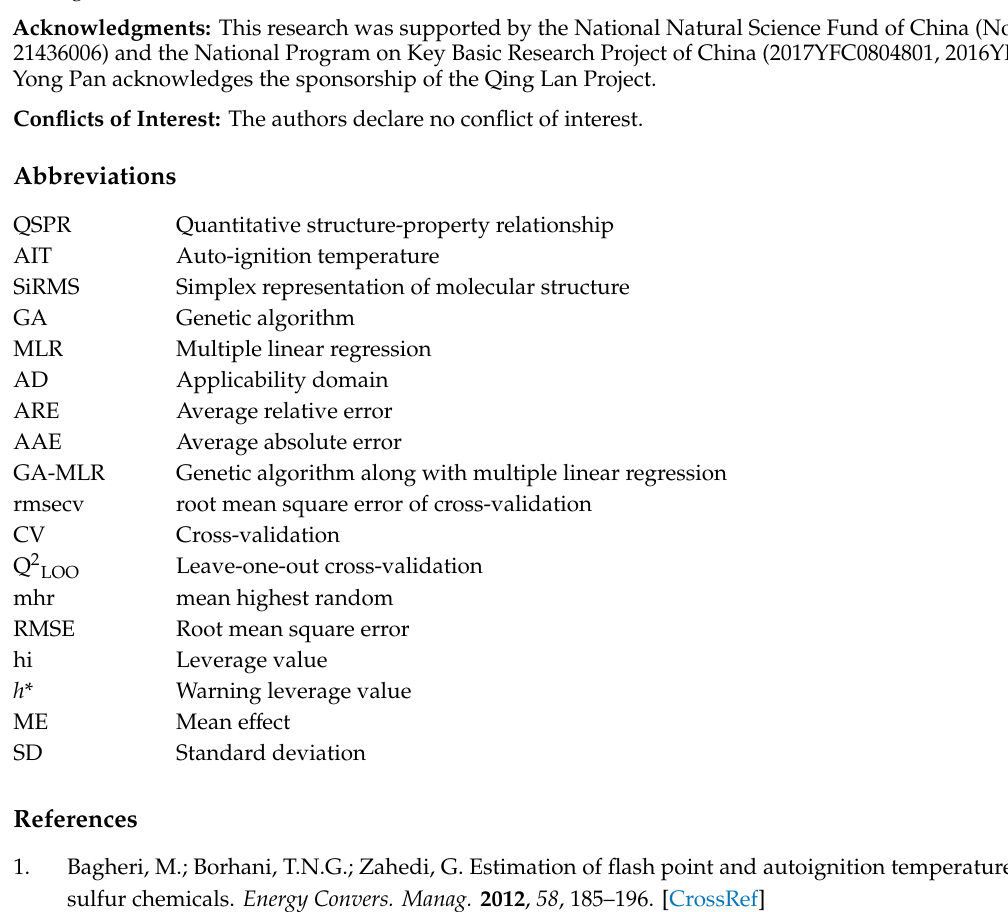
s1. Table S1: A complete list of the compositions of the 132 binary miscible liquid mixtures and their